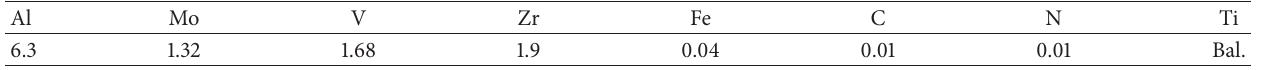
Table 1: The chemical composition of as-received TA15 titanium alloy (wt.%).